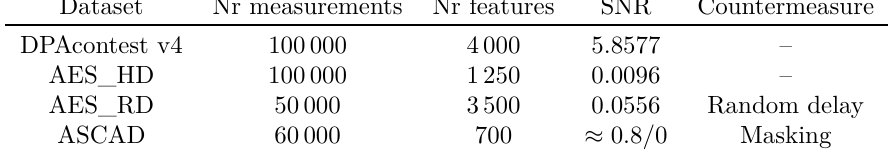
Table 1: Statistical information for all considered datasets. Note, for ASCAD, we show two values for SNR where the first one is for the scenario if the mask is known while the second value is for the unknown